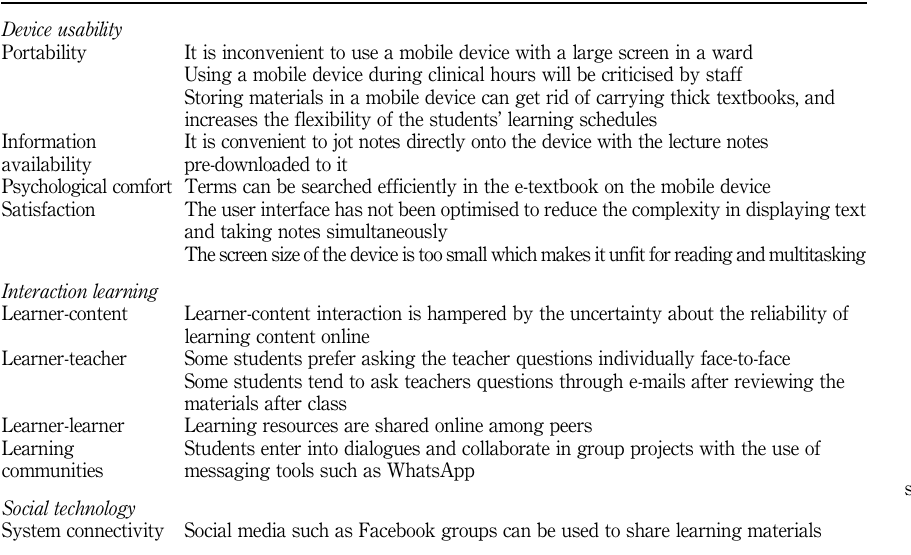
Table I. Summary of